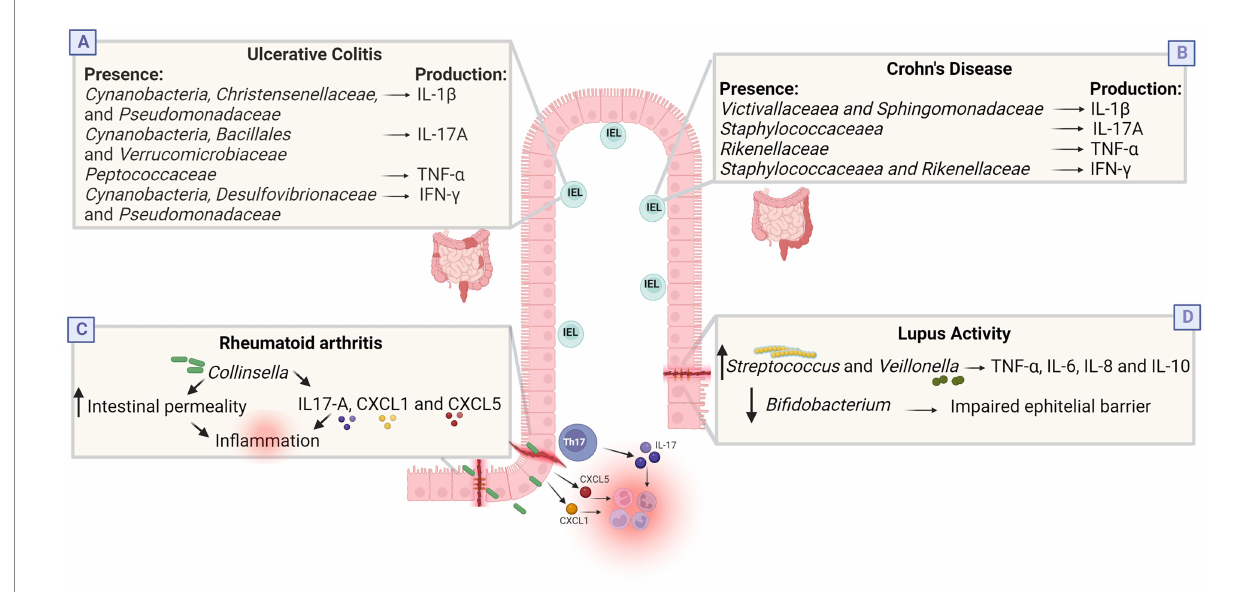
FIGURE 3 Dysbiosis in inflammatory and infectious diseases. (A,B) Cytokines produced by intestinal intraepithelial lymphocytes (IEL) correlate with the relative abundance of some bacterial taxa in IBD. In the UC group, there was positive correlation between the abundances of Cynanobacteria , Christensenellaceae , and Pseudomonadaceae and IL-1 β ; between Cynanobacteria , Bacillales , and Verrucomicrobiaceae and IL-17A; between Peptococcaceae and TNF- α ; and between Cynanobacteria , Desulfovibrionaceae , and Pseudomonadaceae and IFN- γ . In the CD group, there was positive correlation between the abundances of Victivallaceaea and Sphingomonadaceae and IL-1 β ; between Staphylococcaceaea and IL-17A; between Rikenellaceae and TNF- α ; and between Staphylococcaceaea and Rikenellaceae and IFN- γ . (C) Culture with Collinsella reduces the expression of junction proteins, increasing intestinal permeability, and influences the secretion of IL-17A, CXCL1 and CXL5, which can trigger neutrophil recruitment and NFkb activation, possibly increasing pro-inflammatory conditions in RA. (D) Lupus activity was positively associated with the genera Streptococcus , Campylobacter and Veillonella , and negatively correlated with Bifidobacterium . Streptococcus combined with Veillonella enhance the TNF- α , IL-8, IL-6, and IL-10 response while Bifidobacterium is associated with improved gastrointestinal barrier function and suppression of pro- inflammatory cytokines. Together, these changes possibly induce an inflammatory state. Created with